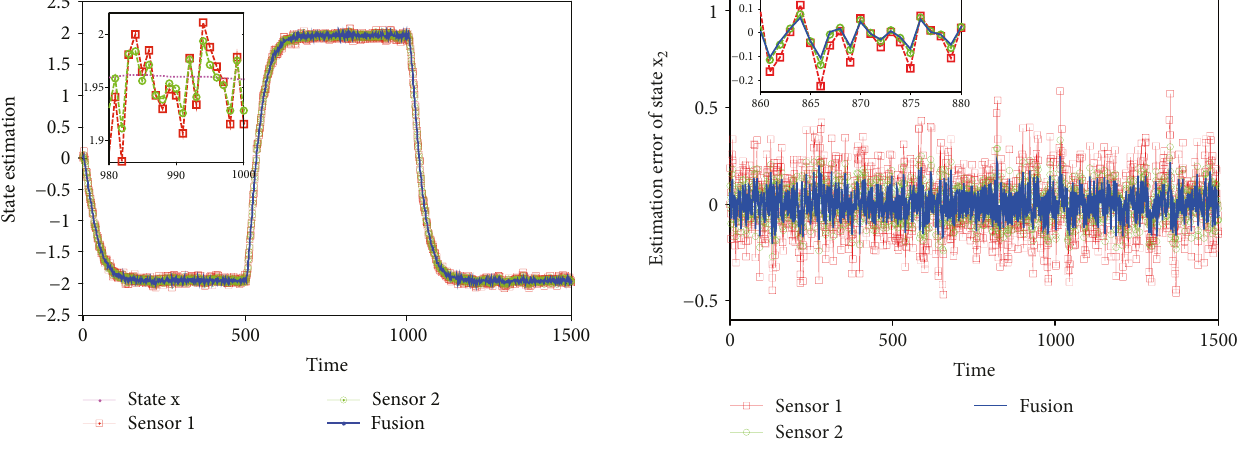
1 (sensor 1, sensor 2, and fusion)